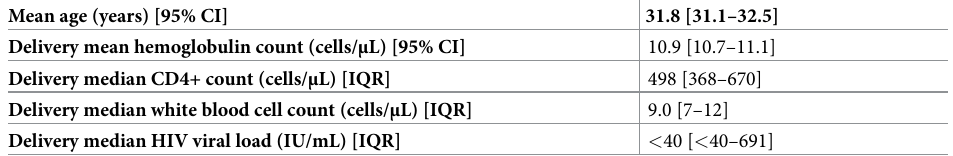
Table 2. Demographics of mothers living with HIV.